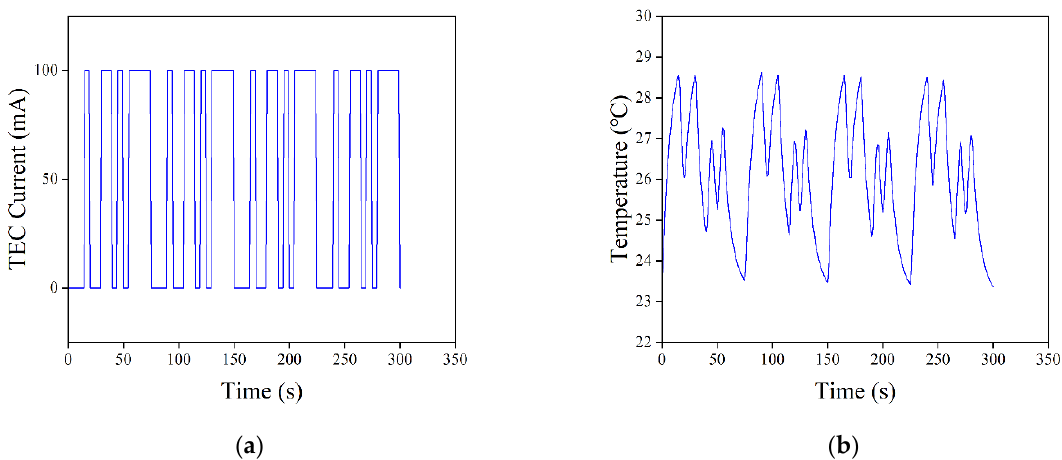
Figure 9. Excitation signal and output response of system identification: ( a ) excitation signal and ( b ) output response.